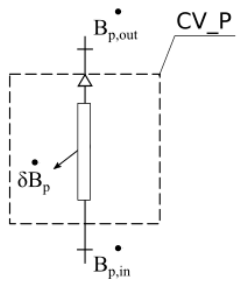
Figure 4. Exergy model for pipes.